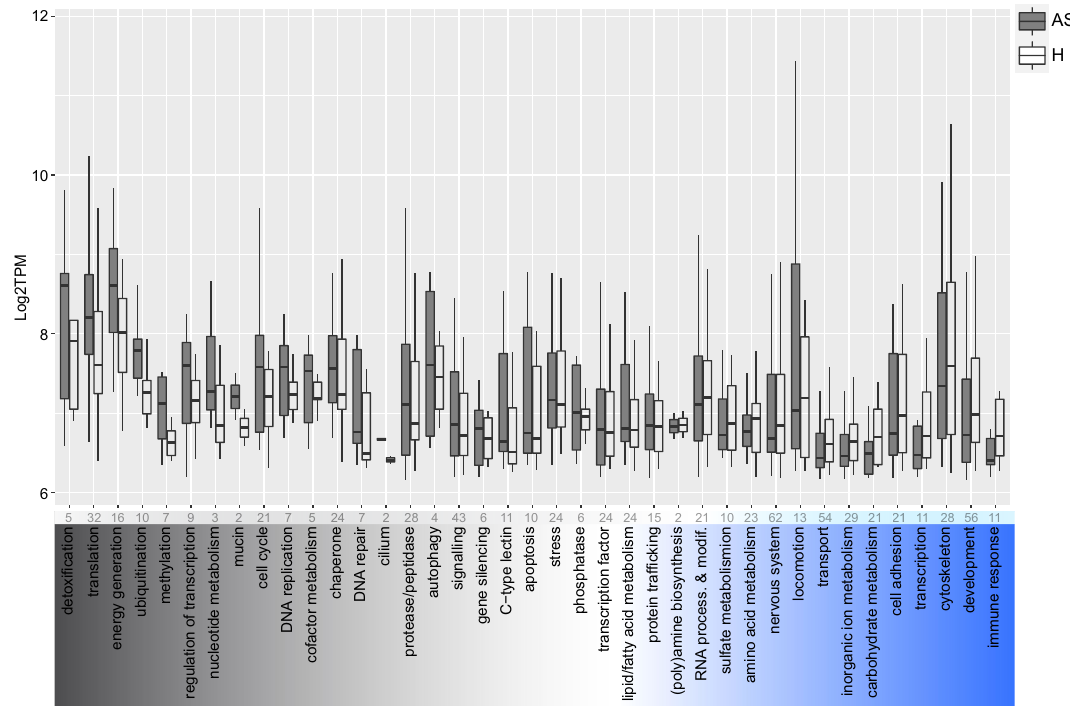
Figure 2. Median gene expression levels of selected L. oneistus metabolic processes among the differentially expressed genes between the hypoxic (H) and anoxic sulfidic (AS) conditions after 24 h. Individual processes among the differentially expressed genes are ordered according to their difference in median expression between the AS and H incubations. Namely, detoxification (far left) had the largest difference in median expression in the AS condition, whereas immune response (far right) had the largest median expression difference in the H condition. The absolute number of genes are indicated at the top of each process. Metabolic processes were manually assigned and confirmed with the automatic annotated eggNOG classification. For specific gene assignments see Data S1. Some genes are present in more than one functional category and processes comprising only one gene are not displayed in the figure but listed in Data